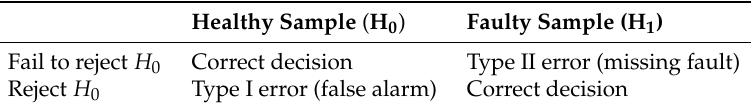
Table 5. Scheme for the presentation of the results in Table